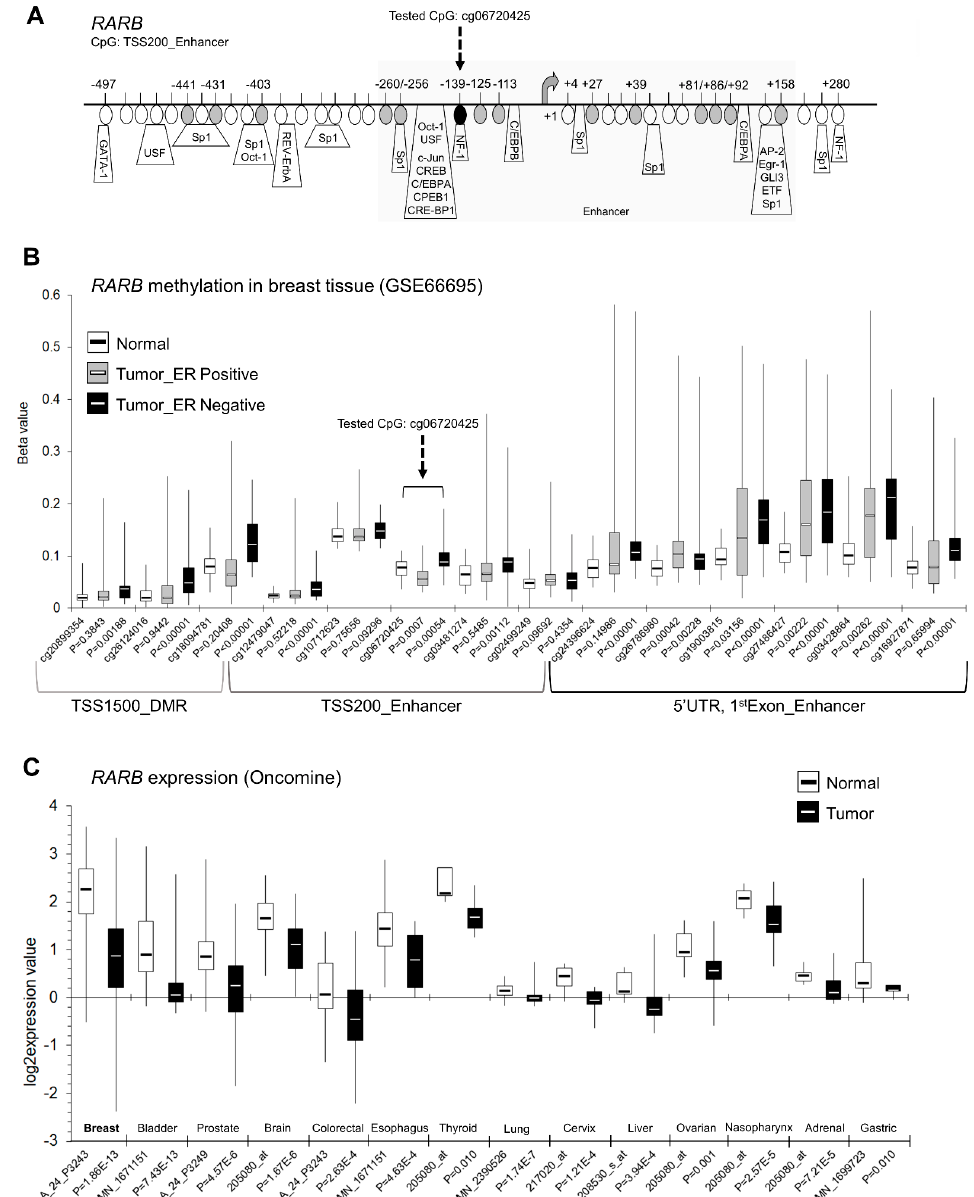
Figure 3. Relevance of DNA methylation-mediated silencing of RARB tumor suppressor in human breast cancer in vivo. ( A ) A map of the RARB proximal promoter region (Human GRCh37/hg19 Assembly) including an enhancer region. The methylation-sensitive restriction analysis (MSRA)-tested CpG site (located within the enhancer region of the RARB promoter, -139 bp from transcription start site (TSS); cg06720425 on Illumina 450K microarray platform; chr3: 25469694) is depicted as a black circle, indicated with black dashed arrow. The neighboring CpG sites [-441 bp to +158 bp from TSS] covered on Illumina 450K array are depicted as gray circles. Putative transcription factor binding sites are indicated as predicted using TransFac. ( B ) Methylation status of these 14 CpG sites (black and gray circles on the gene map) within the RARB proximal promoter region, covered on Illumina 450K array and expressed as beta value in breast tumors based on publicly available Illumina 450K data (GSE66695). The tested CpG site, cg06720425, is indicated with black dashed arrow. Beta value, the methylation score for a specific CpG site with any values between 0 (unmethylated) and 1 (completely methylated), according to the fluorescent intensity ratio. ( C ) Breast cancer gene expression microarray data for RARB from Oncomine. The normal versus tumor gene expression data are presented as log2-transformed median centered per array, and SD-normalized to 1 per array. The demonstrated changes are statistically significant ( P < 0.05).